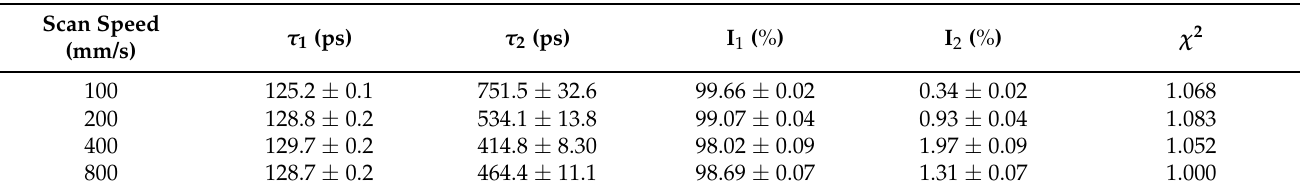
Table 4. Results of deconvolution using two unconstrained lifetime fitting parameters for LPBF molybdenum with reduced χ 2 values.